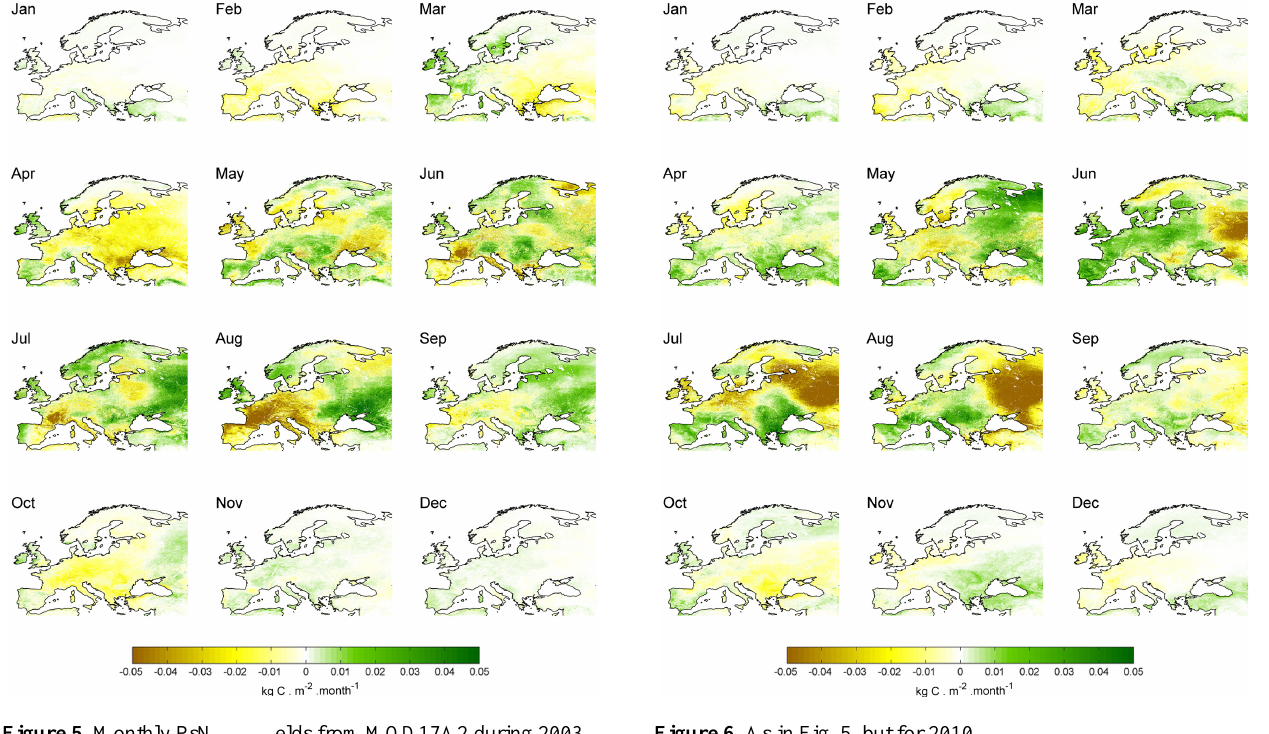
2003 and 2010, respectively, for T anom , P anom , SW1 anom and SW4 anom .